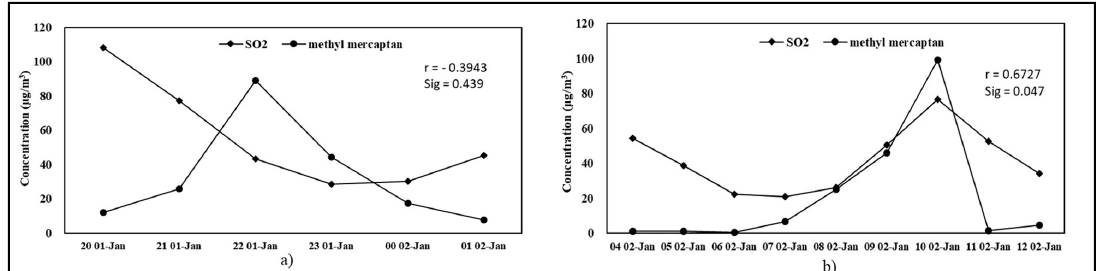
Figure 6. Examples of consistency judgment: ( a ) an example of the inconsistency, r = − 0.3943, Sig = 0.439; ( b ) an example of the strong consistency, r = 0.6727, Sig = 0.047. r is the Pearson correlation coefficient in the range [–1, 1]. The sign indicates the direction of the relationship, while the magnitude indicates the strength of the relationship. Sig represents the significance test, in which 0.05 is set for statistical significance in general. A value of 0.06727 means strong correlation, − 0.3943 means negative weak correlation. 0.01 < Sig < 0.05, a statistical significance; 0.001 < Sig < 0.05, highly statistically